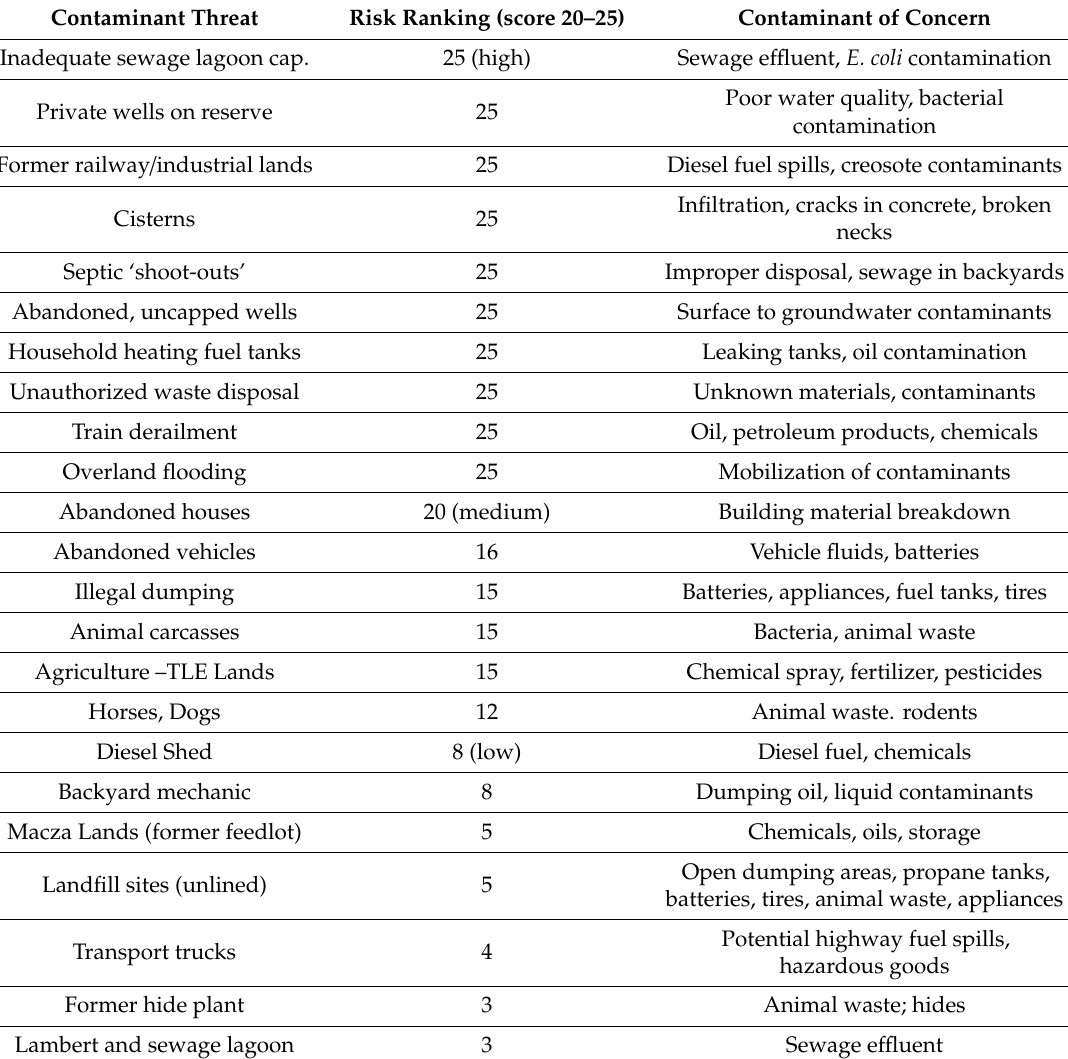
Table 1. Potential water contaminants at Muskowekwan First